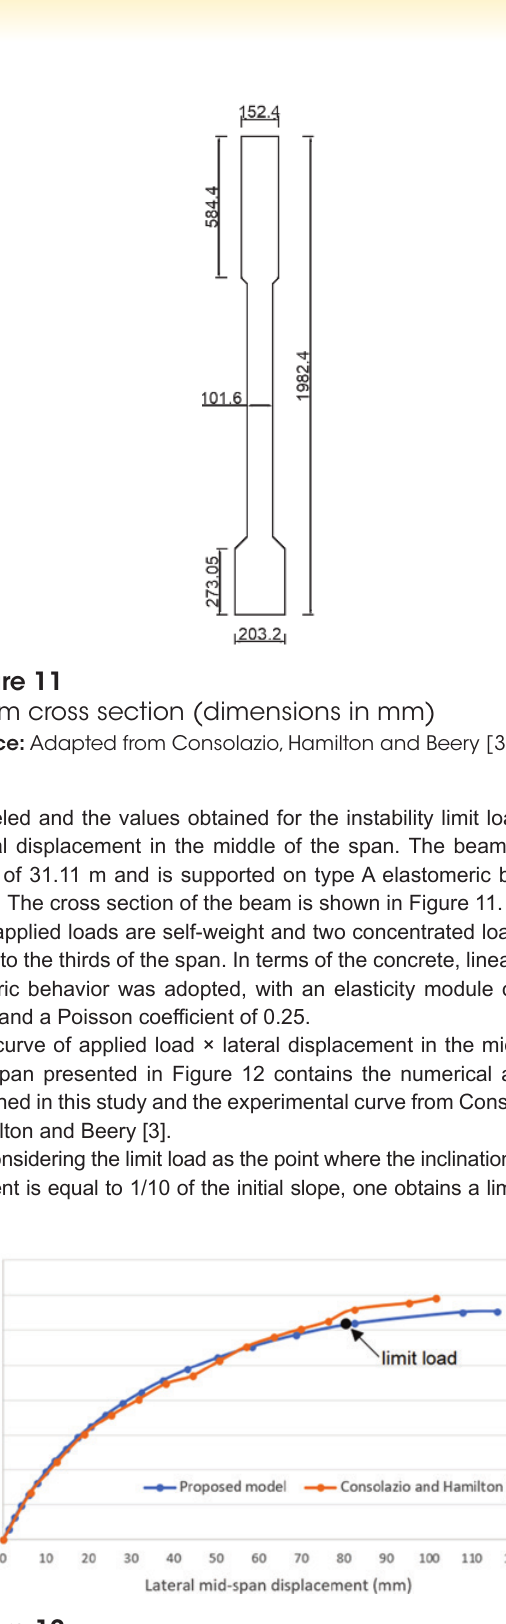
Figure 12 Applied load × Lateral mid-span